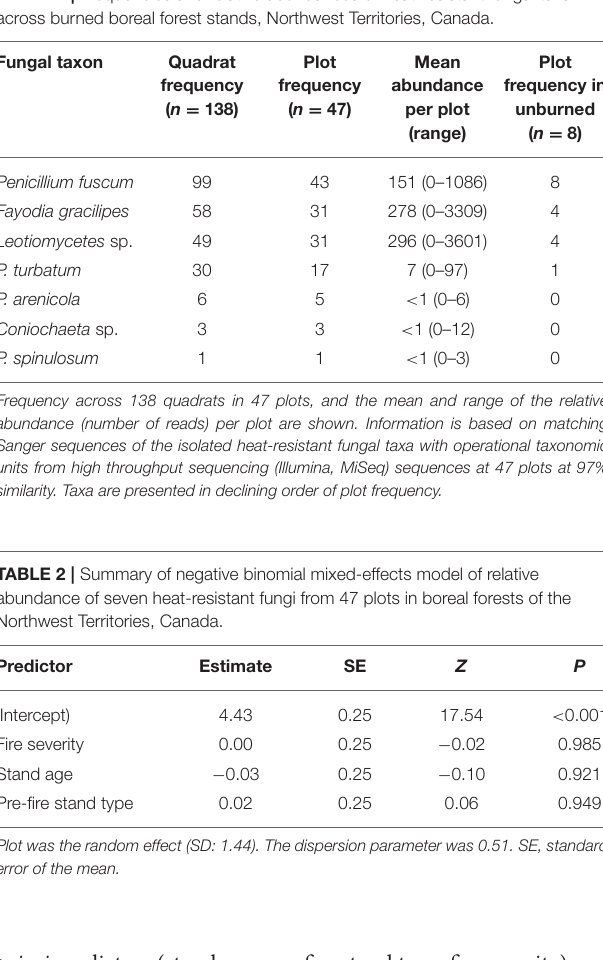
priori predictors (stand age, pre-fire stand type, fire severity) and